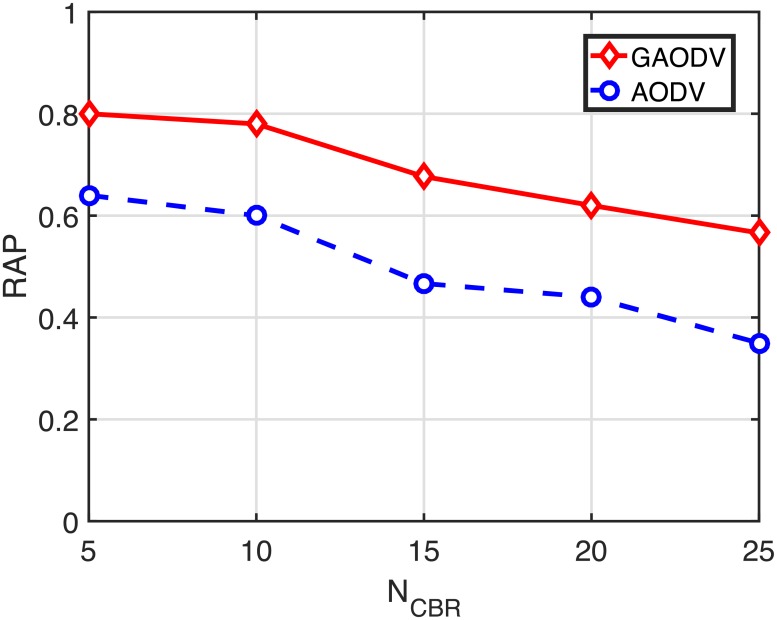
Route acquisition probability for the change of NCBR when vmax = 5 m/s.